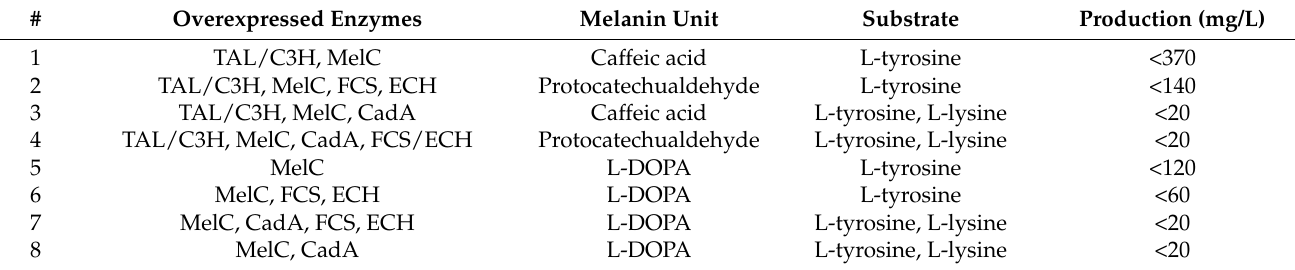
Table 2. Production of melanin complexes by E. coli depending on the MelC, TAL/C3H, CadA, and FCS/ECH enzyme modules from L-tyrosine and